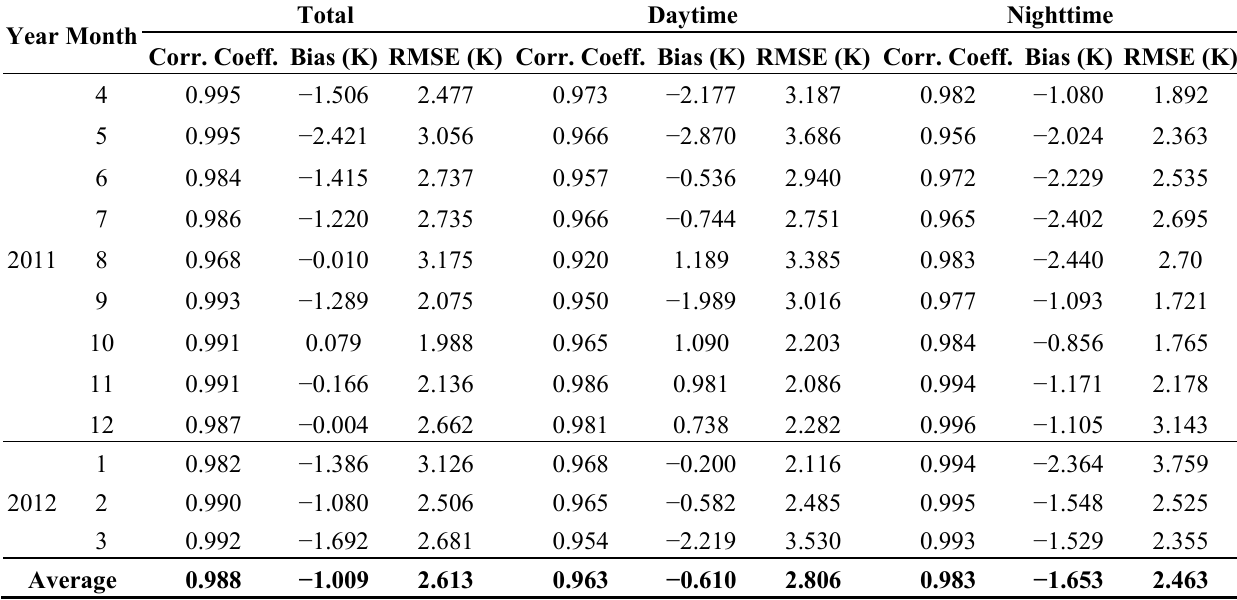
Table 3. Evaluation results comparing COMS LST data to MODIS LST data during the day and night times. Corr. Coeff., correlation